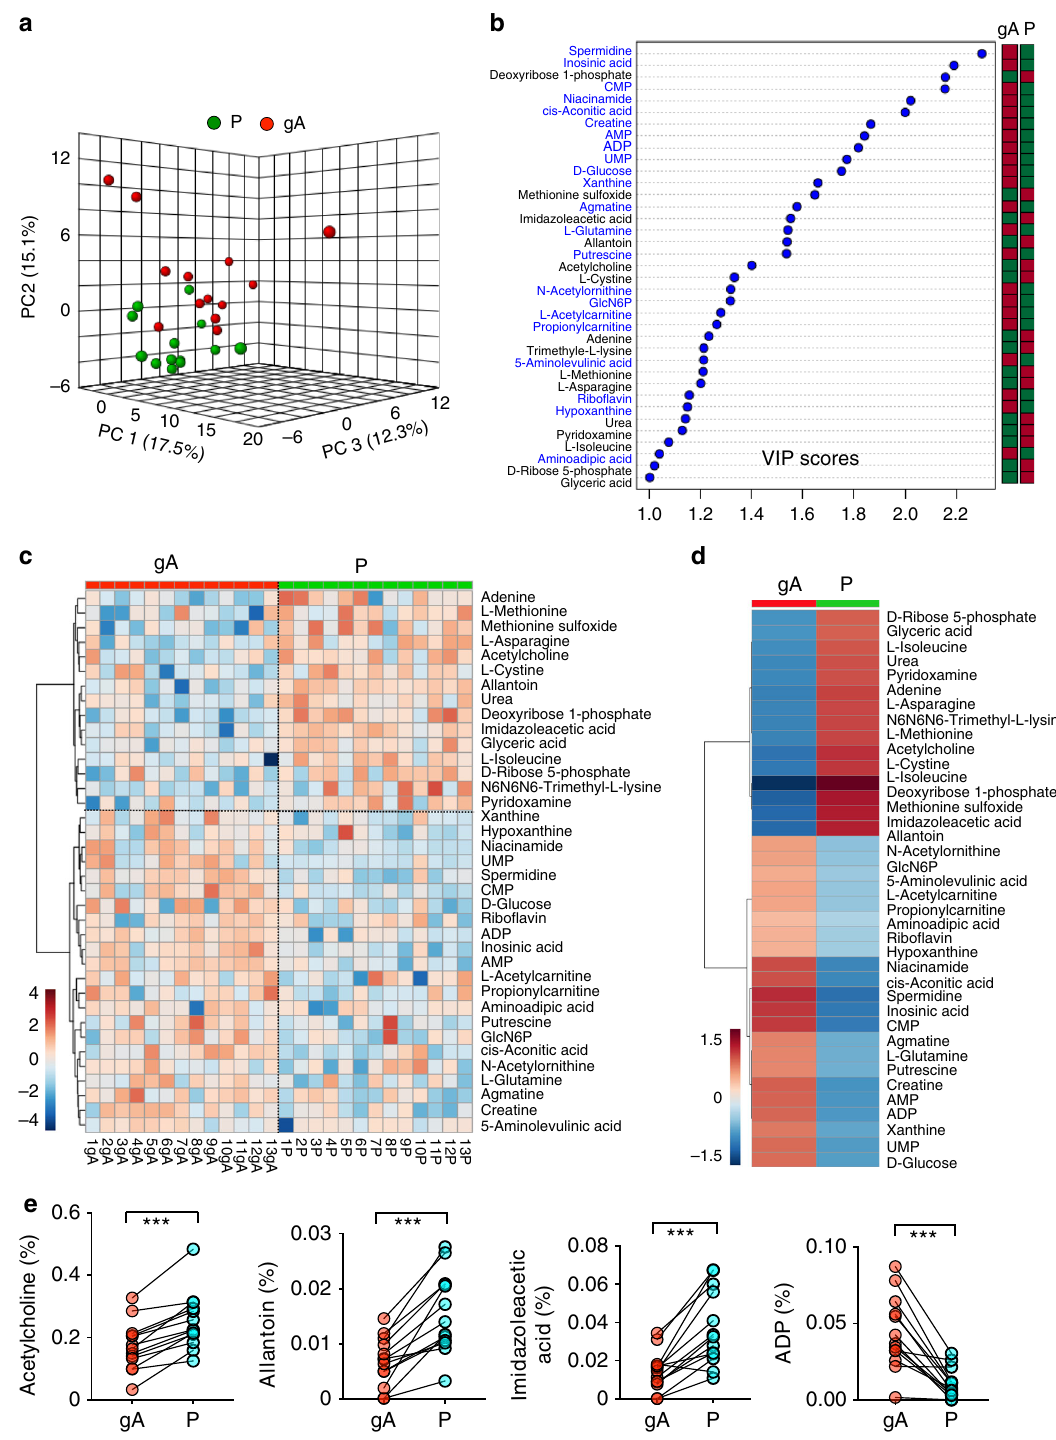
Fig. 3 Paired comparison of metabolomes from glioma artery and dorsal pedal vein plasma. a PCA of the metabolomes of glioma artery (gA) and dorsal pedal vein (P) samples from 13 patients. Three PCs explain 44.9% (15.1%, 17.5%, and 12.3%) of variance between gA and P. PC scores are indicated as %; circles indicate individual samples from the glioma artery and dorsal pedal vein. b VIP scores of metabolites between glioma artery(gA) and dorsal pedal vein (P) plasma samples. The names of the metabolites enriched in glioma arterial blood (gA) are labeled with blue text. The columns to the right indicate whether the abundance of each metabolite is enhanced (red box) or reduced (green box) in each plasma group. c Heatmap representation of 37 of 107 metabolites of blood plasma from glioma artery (gA) and dorsal pedal vein (P) samples. Warm color indicates higher concentration. d A heatmap representation of 37 metabolites (VIP score > 1) in blood samples from glioma artery (gA) and dorsal pedal vein (P). All metabolites are listed on the right side of the map. Color bar (bottom left), warm color indicates higher concenration. e Relative abundance (normalized by TIC, y -axis) of four representative metabolites (Acetylcholine, Allantoin, Imidazoleacetic acid, ADP) from glioma artery (gA) and dorsal pedal vein (P) samples. *** p < 0.001 ; two-tailed paired t -test. GlcN6P, Glucosamine 6-phosphate. CMP, Cytidine monophosphate. AMP, Adenosine monophosphate. ADP, Adenosine